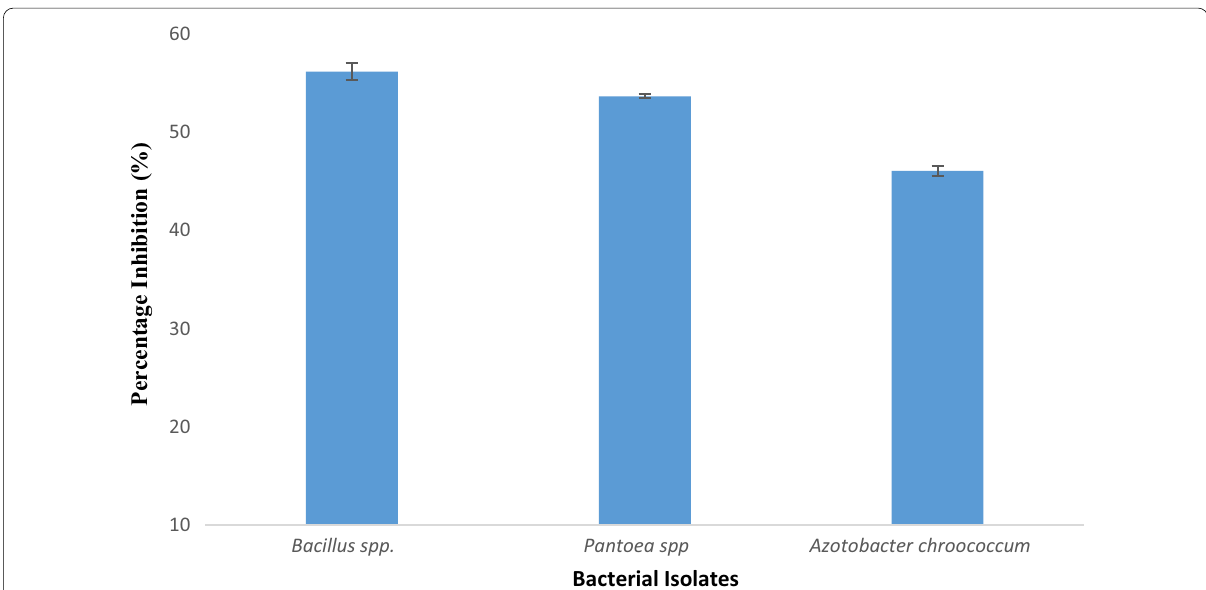
Fig. 4 Antagonistic activities of termite mound soil bacteria against F.